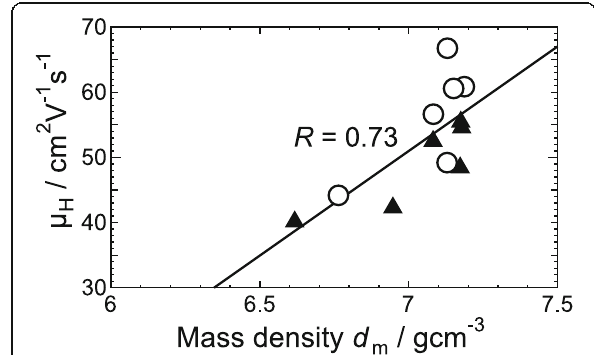
Fig. 5 Relationship between Hall mobility μ H and mass density d m of a -ITO films grown at an OFR of 20 sccm (triangles) or 30 sccm (circles). The solid line represents a linear fit to all the data with its correlation coefficient R specified